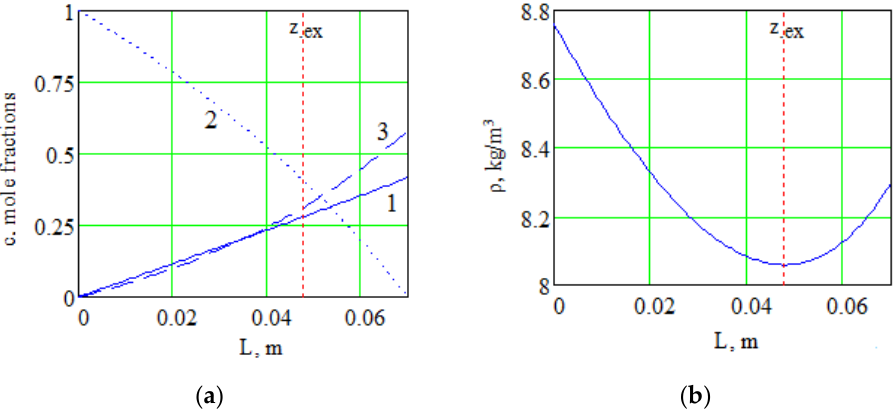
Figure 4. Changes in the concentrations of components ( a ) and the total density ( b ) along the length of the channel for the system 0.4163H 2 + 0.5837 СО 2 − N 2 : 1—H 2 ; 2—N 2 ; 3—CO 2